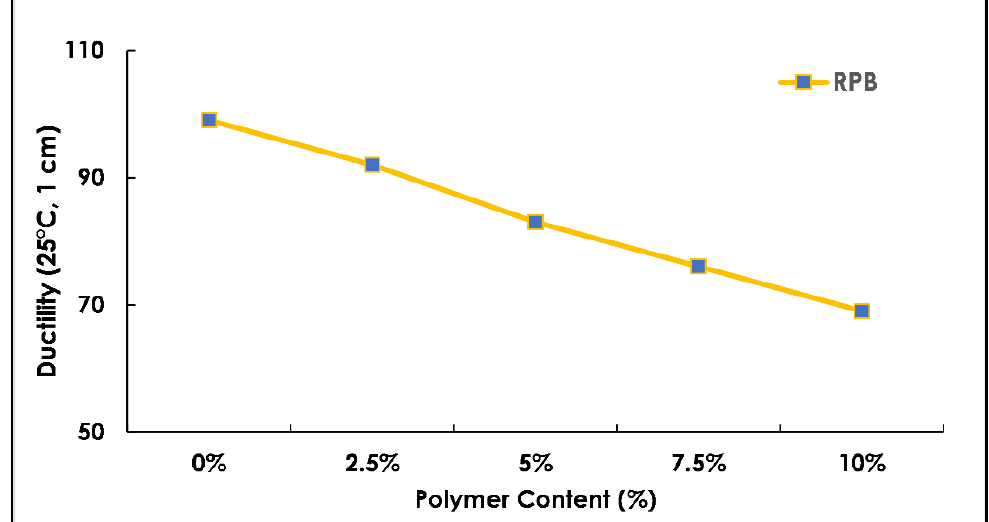
Figure 8 . Ductility test results with varying polymer content (%). Figure 8. Ductility test results with varying polymer content